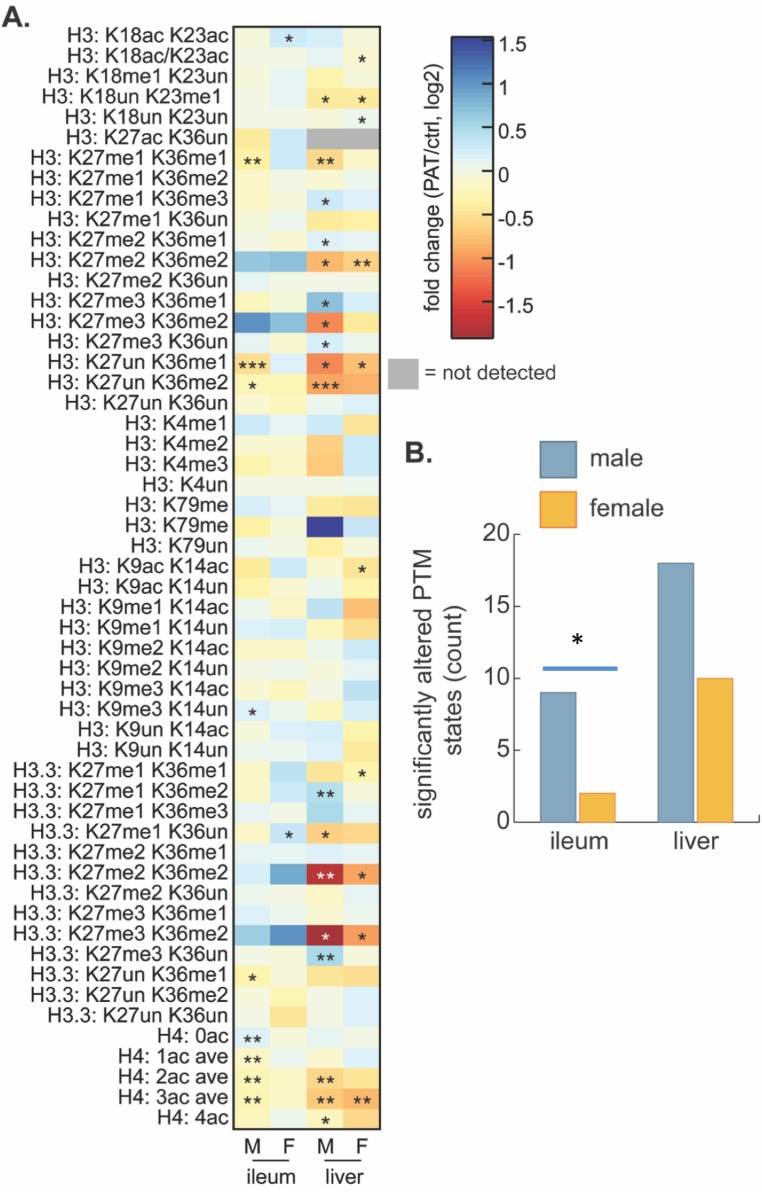
Effect of 1PAT on tissue-specific histone PTM state in P23 mice.(A) Fold-change (log2) of 65 unique histone PTM states in male (M) and female (F) ileal and hepatic tissues. Statistical significance determined by Welch’s t test (n = 4–5 mice per group). *p<0.05, **p<0.01, and ***p<0.001. (B) Summation of significantly altered histone peptides in male and female ileum and liver; significance determined by Chi square analysis. *p<0.05. [See also Supplementary file 5].